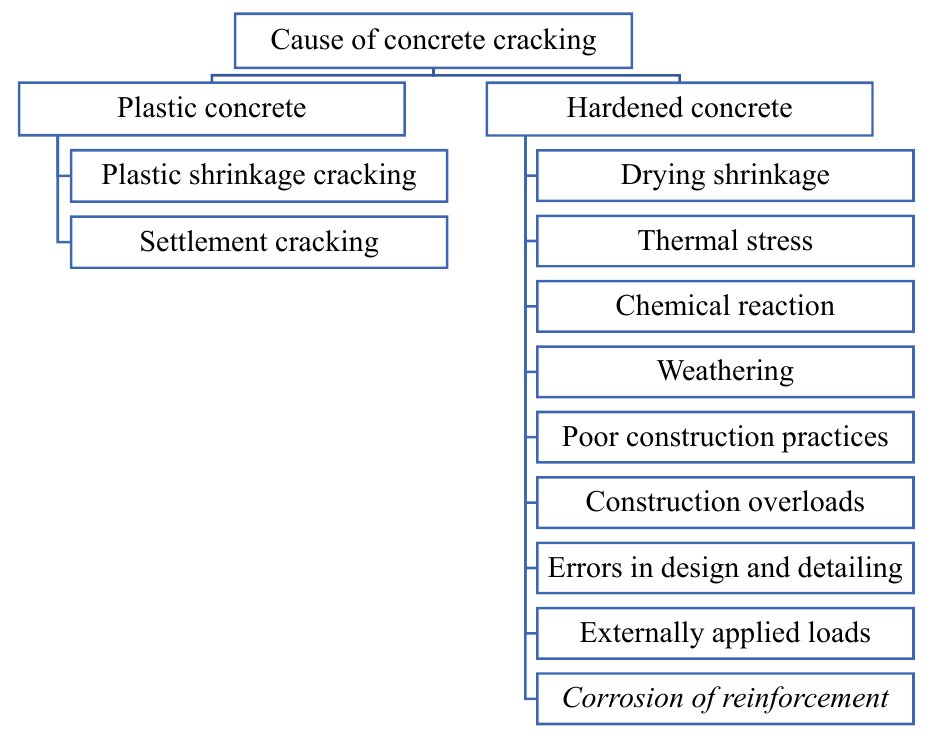
Figure 2. Causes of concrete cracking.